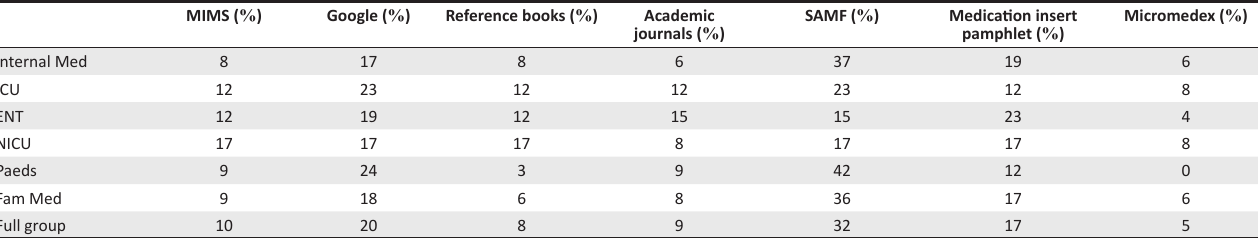
TABLE 6: Sources consulted by participants to obtain information on medicines.